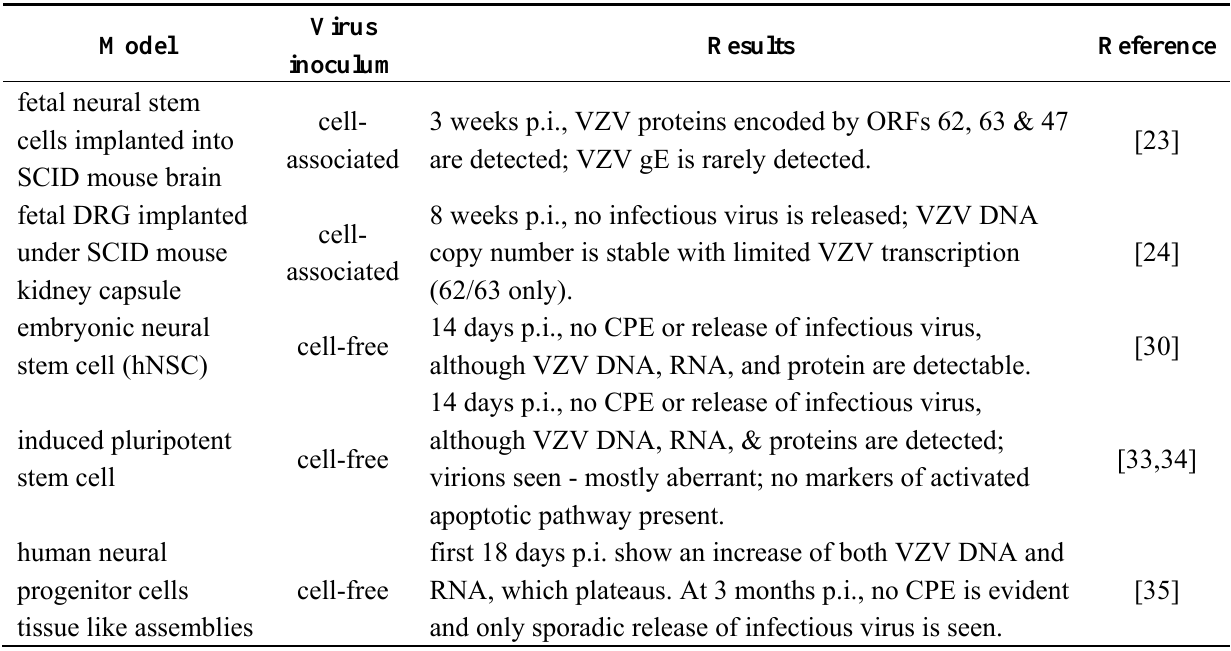
Table 1. Current models of non-productive VZV infection of human